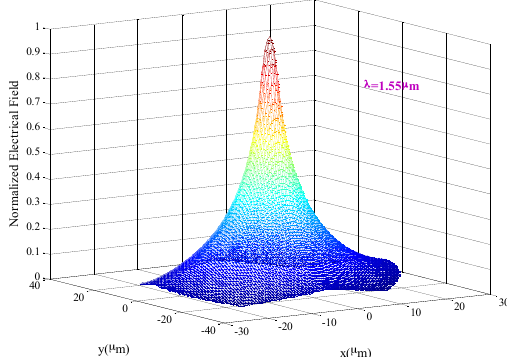
Figure 2. Normalized electrical field distribution in WII type optical fiber with initial structural parameters at 1.55 µ m.